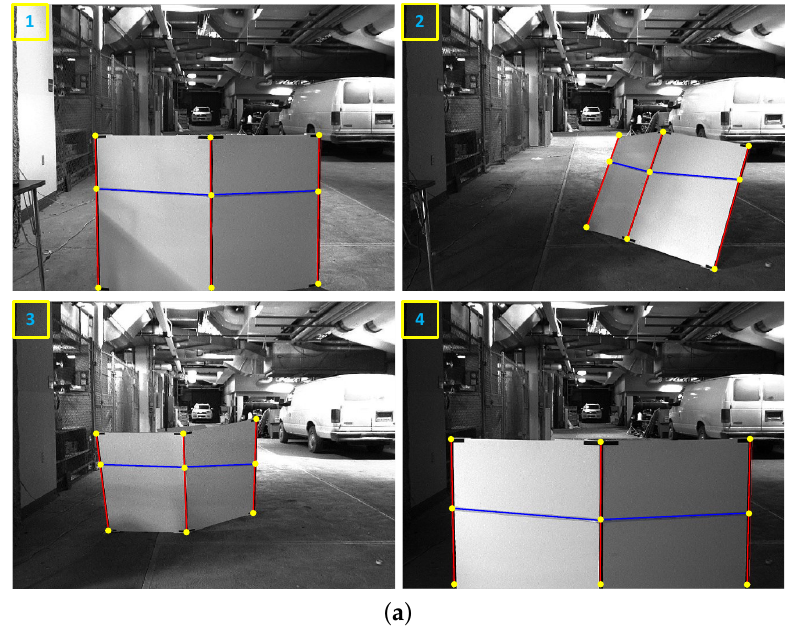
Figure 5. Ground truth generation: we detected the LiDAR scan using an IR camera (blue circle) ( Left ). The detected scan line was visible on a monitor ( Right